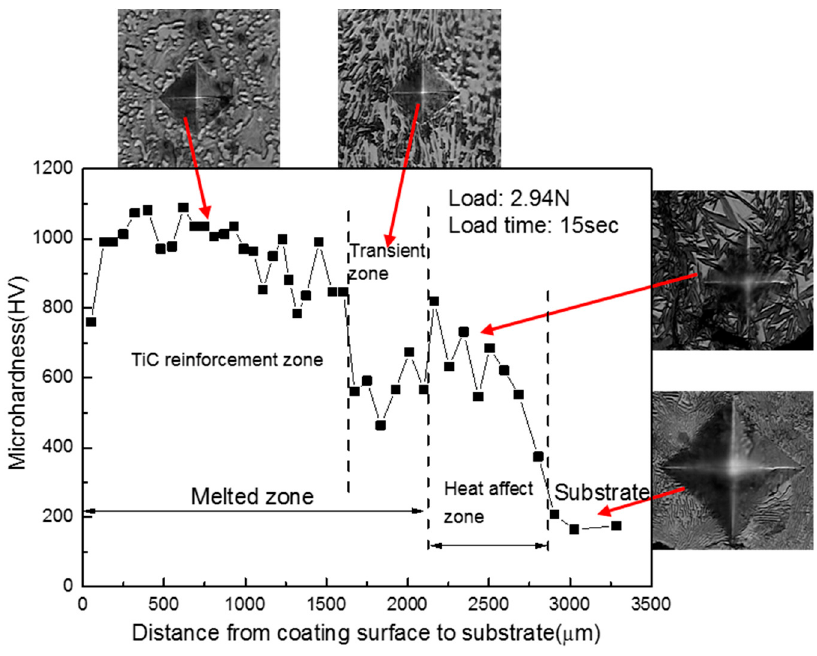
Figure 8. The microhardness distribution with the depth from the coating surface to the substrate in cross-section.